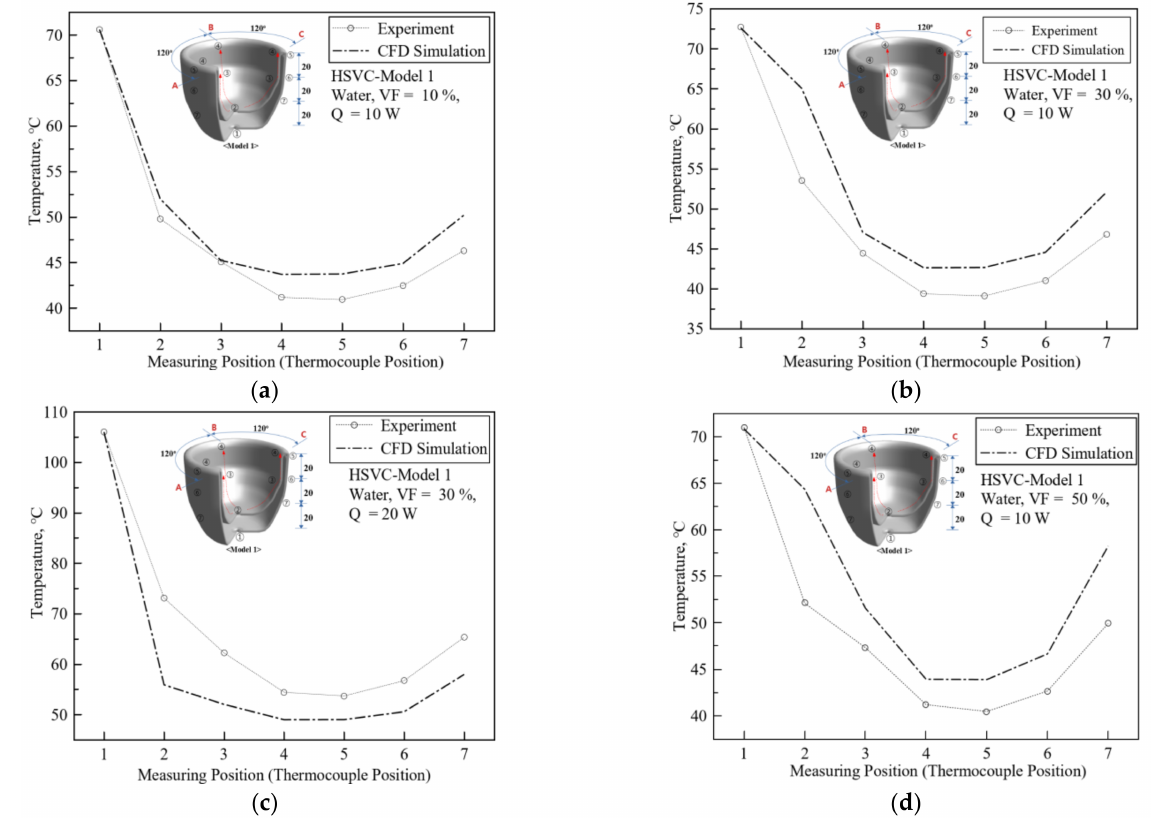
Figure 20. Comparison of the CFD and the experiment, Model 1. ( a ) VF = 10%, Q = 10 W. ( b ) VF = 30%, Q = 10 W. ( c ) VF = 30%, Q = 20 W. ( d ) VF = 50%, Q = 10